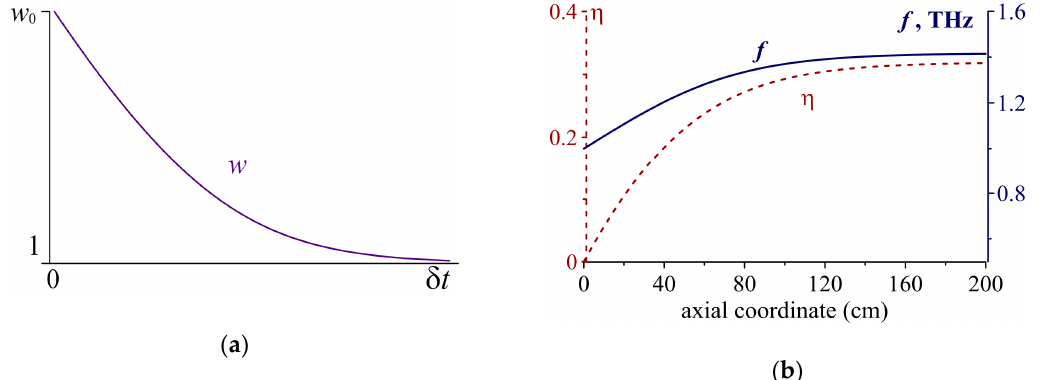
Figure 2. Cyclotron radiation of a moving plane: ( a ) change in electron energy; ( b ) current radiation frequency and e ffi ciency for an initial particle energy of 6 MeV, normalized transverse velocity β ⊥ 0 = 1 γ surface density σ = 1.2 × 10 − 4 C / m 2 , and magnetic field H 0 = 27 kOe, H u = 0 .